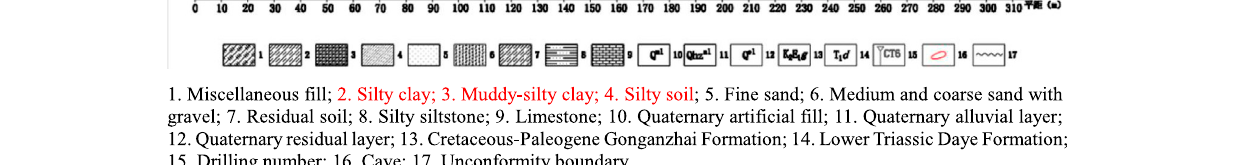
FIGURE 6 | Geological pro fi le of Qiaomuwan collapse area in Fenghuo Village. 1. Miscellaneous fi ll; 2. Silty clay; 3. Muddy-silty clay; 4. Silty soil; 5. Fine sand; 6. Medium and coarse sand with gravel; 7. Residual soil; 8. Silty siltstone; 9. Limestone; 10. Quaternary arti fi cial fi ll; 11. Quaternary alluvial layer; 12. Quaternary residual layer; 13. Cretaceous-Paleogene Gonganzhai Formation; 14. Lower Triassic Daye Formation; 15. Drilling number; 16. Cave; 17. Unconformity boundary.